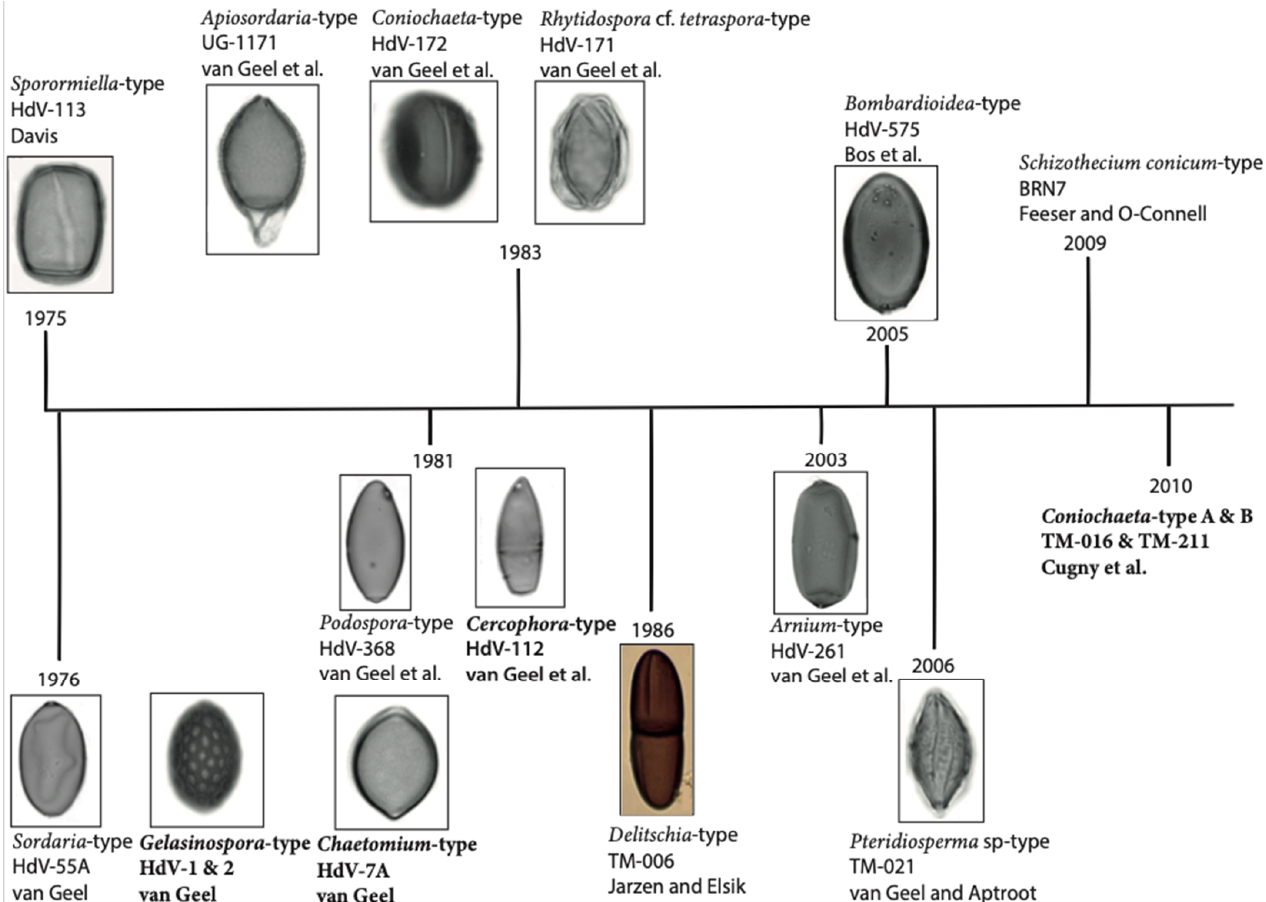
Figure 8. Timeline of when SCF were discovered and who identified them. From oldest to youngest: Sporormiella-type ascospore [30]. Sordaria-type ascospore [30]. Gelasinospora-type ascospore [30]. Chaetomium-type ascospore [30]. Podospora-type ascospore [30]. Cercophora-type ascospore [30]. Apiosordaria-type [30]. Coniochaeta-type [30]. Rhytidospora cf. tetraspora-type [30]. Coniochaeta ligniaria-type [30]. Delitschia-type [13]. Arnium-type [30]. Bombardioidea-type [30]. Pteridiosperma-type [30]. Schizothecium conicum-type. Coniochaeta-type A and B. (Adapted after Baker et al. [58]). Citations in the caption refer to the source of the image.